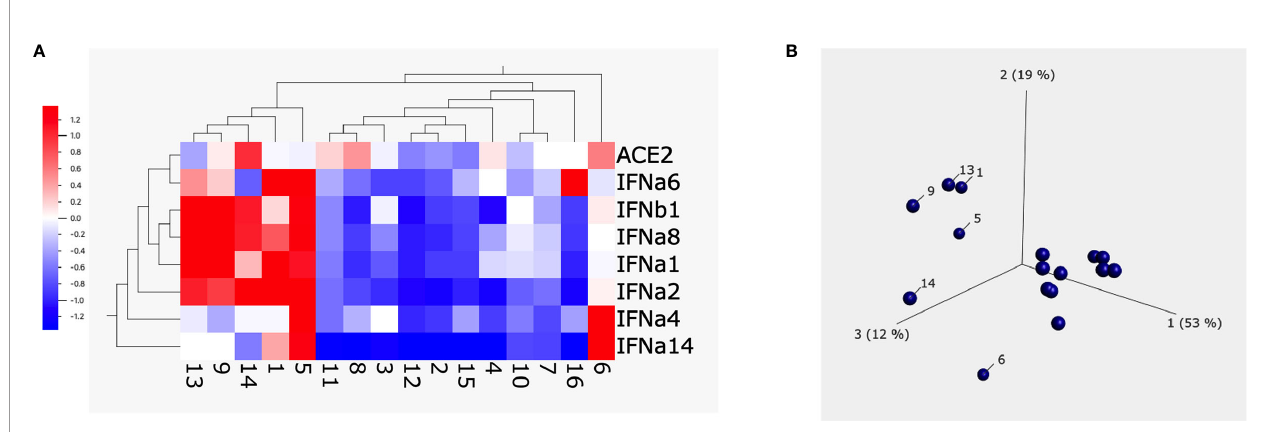
FIGURE 5 | The heatmap and PCA plot of ACE2 and type I interferons after spike protein treatment. Heatmap (A) and PCA (B) were built up using Qlucore Omics Explorer software. The numbers below the heatmap and in the PCA plot are the animal IDs. Each dot presents one animal. The scale in (A) is the relative expression level of the